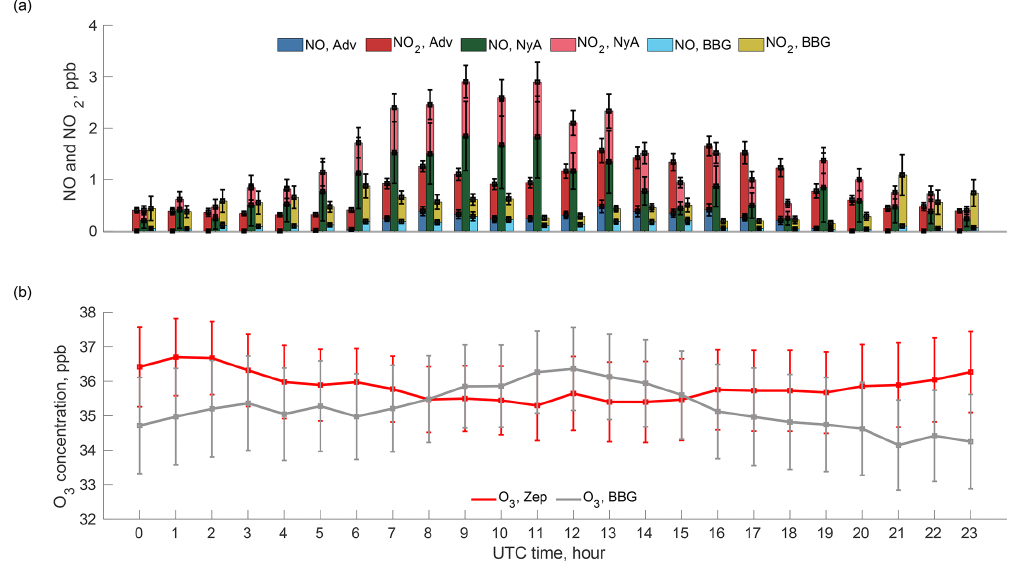
Figure 5. (a) Variation of measured NO and NO 2 concentrations depending on the time of the day (in UTC) in Adventdalen (Adv), Ny- Ålesund (NyA) and Barentsburg stations (BBG). (b) Variation of measured O 3 concentration depending on the time of the day (in UTC) at the Zeppelin (Zep) and Barentsburg stations (BBG). The whiskers show standard error of the mean for each